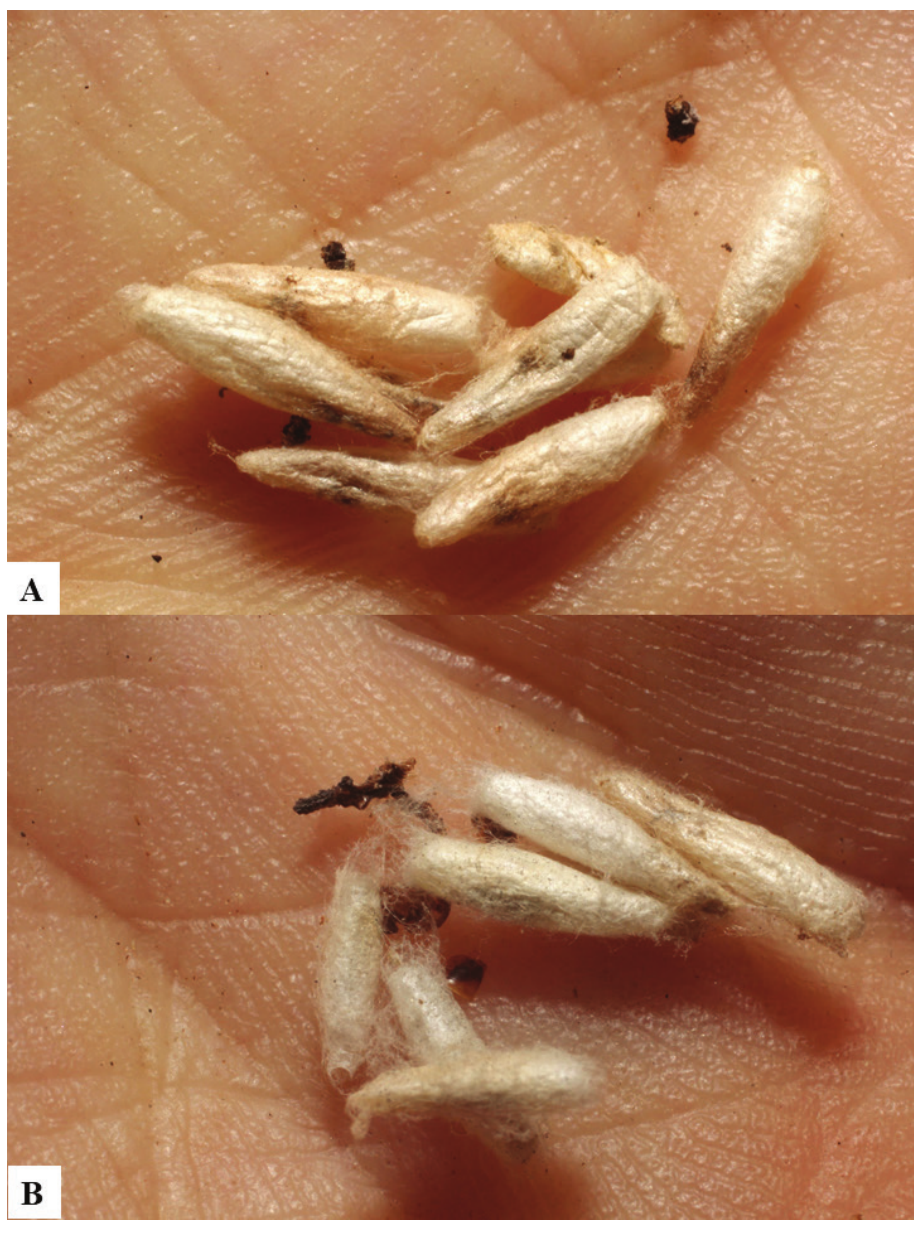
Figure 17. A, B Cocoons of Dolichogenidea yeimycedenoae sp.